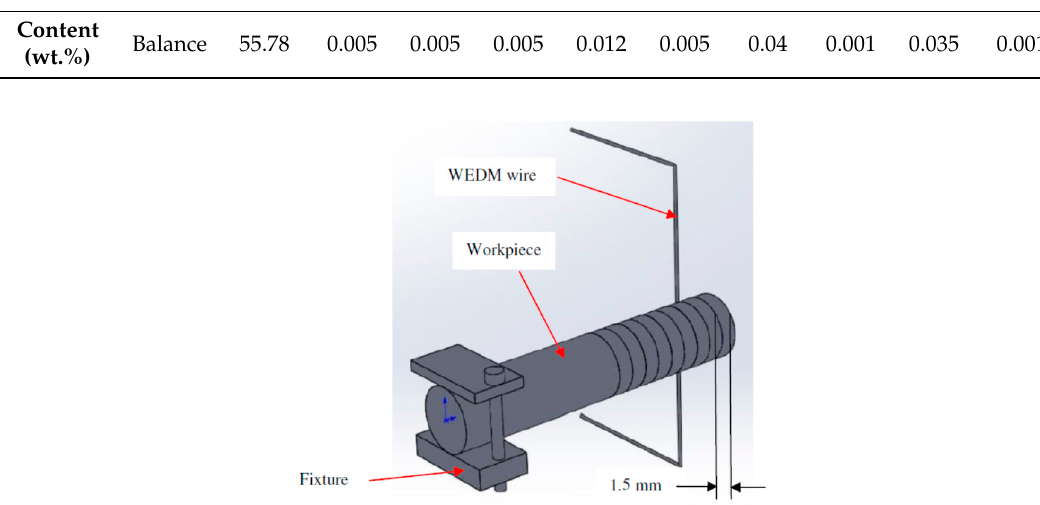
Figure 1. Schematic representation of wire electrical discharge machining (WEDM) process. Table 2. Process parameters and their levels.